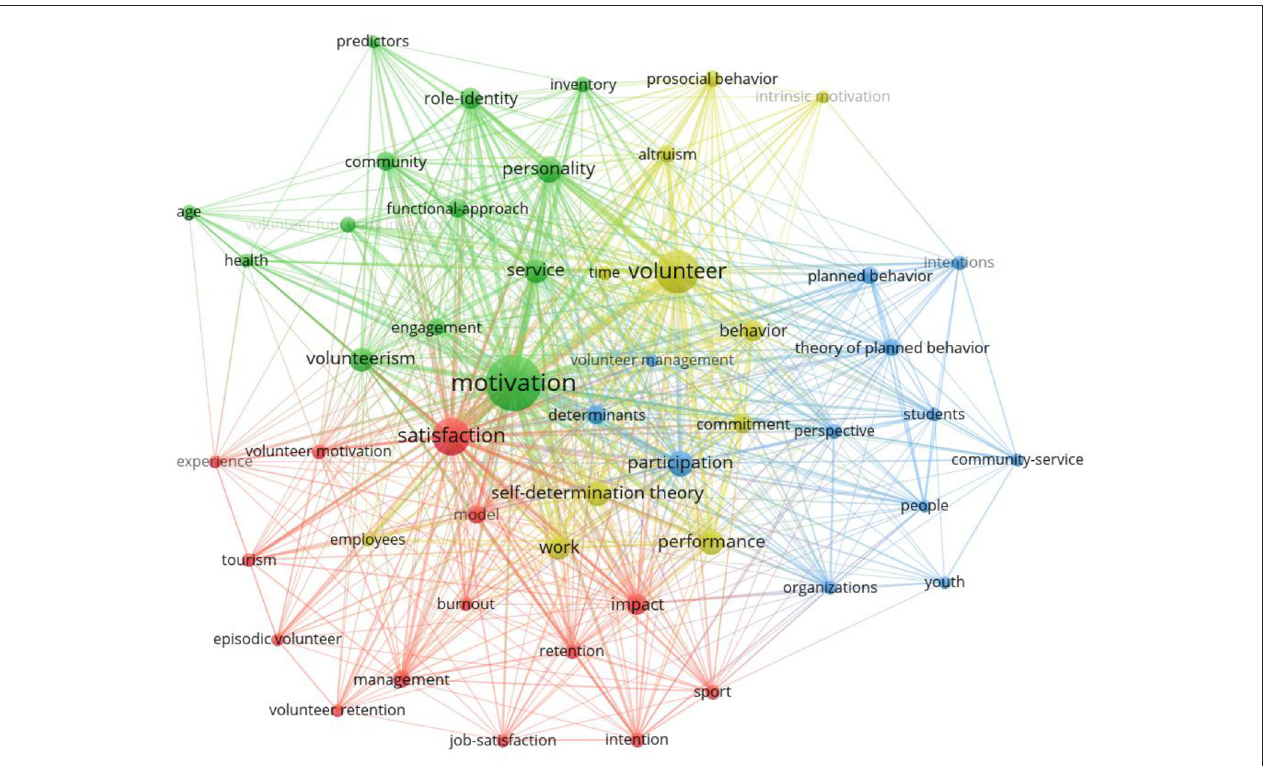
FIGURE 3 | Co-occurrence of keywords.